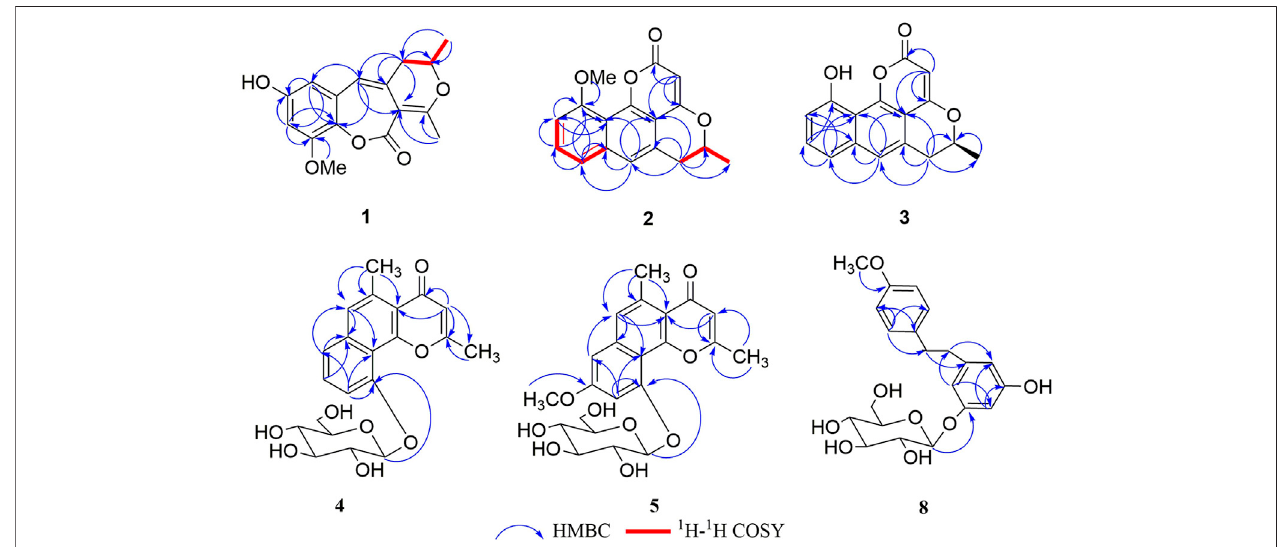
FIGURE 2 | Key HMBC for compounds 1 – 5 , and 8 , and 1 H – 1 H COSY correlations for 1 and 2 .